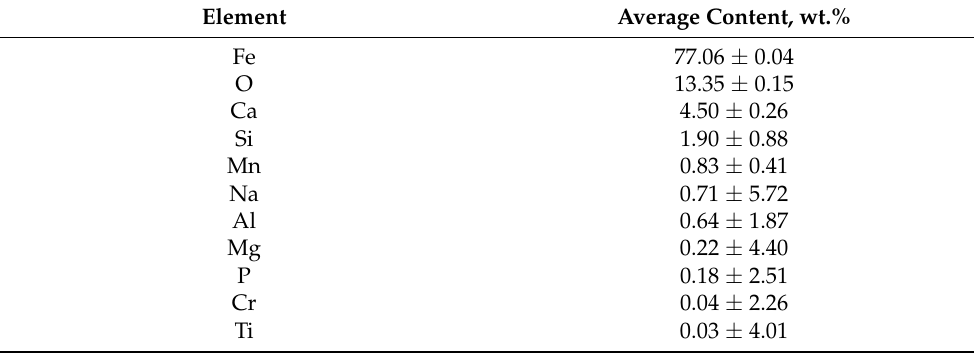
Table 1. Chemical composition of mill scale waste.